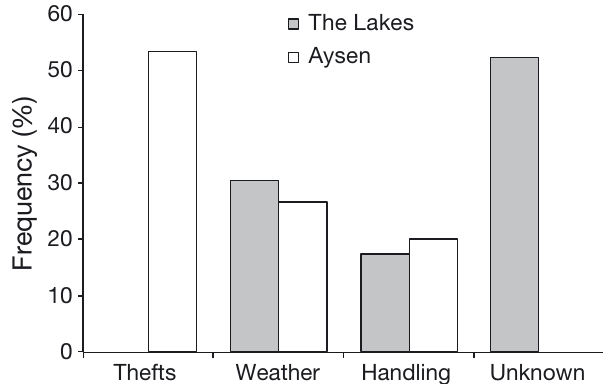
Fig. 3. Main technical issues associated with salmonid es- capes, according to reports by salmonid farm companies in the Lakes (filled bars) and Aysen (open bars) regions of Chile (see Fig. 2) during the period 2004 to 2009. Source: National Fisheries Services and Chilean Navy (unpubl.